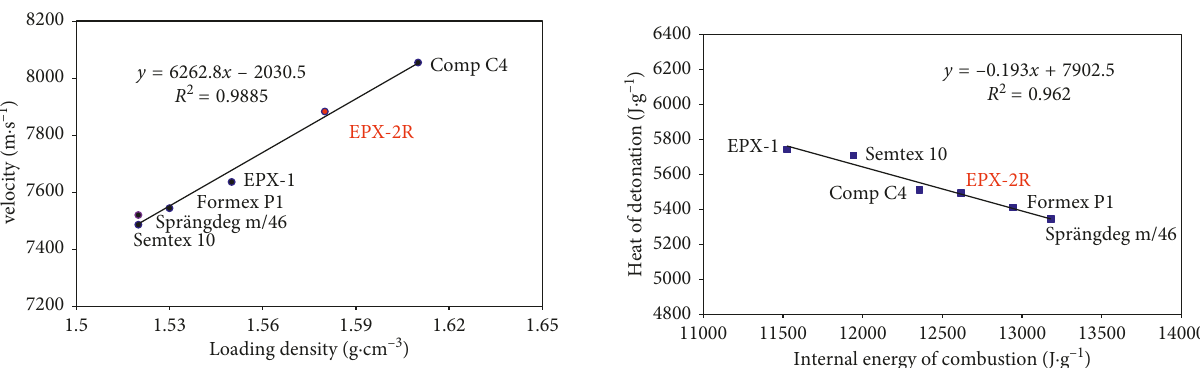
Figure 3: A relationship of the loading densities versus the ex- perimental detonation velocities.